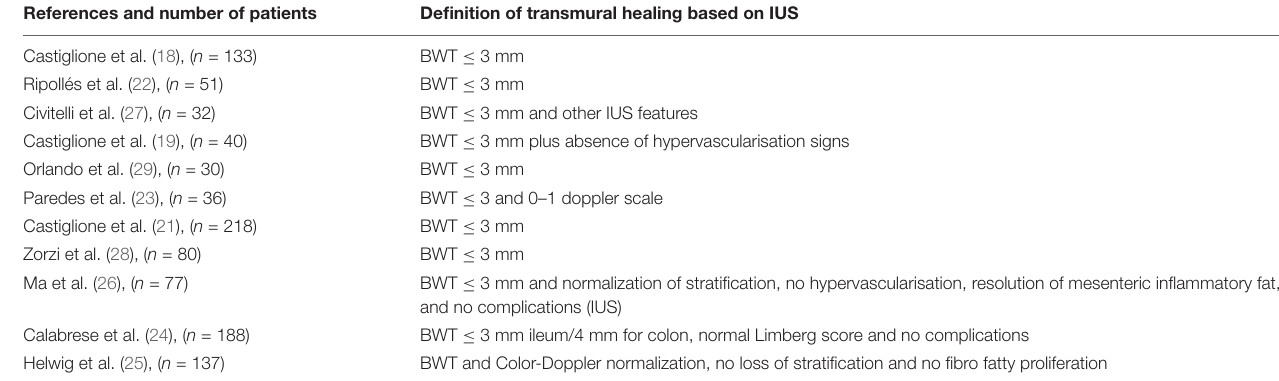
TABLE 1 | Definitions of transmural healing (TH).